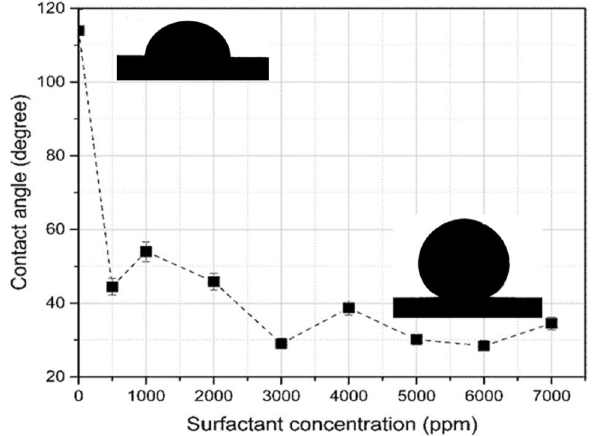
Fig. 14 Contact angle results of crude oil droplets in the presence of the Vitagnus surfactant with concentrations of 500–7000